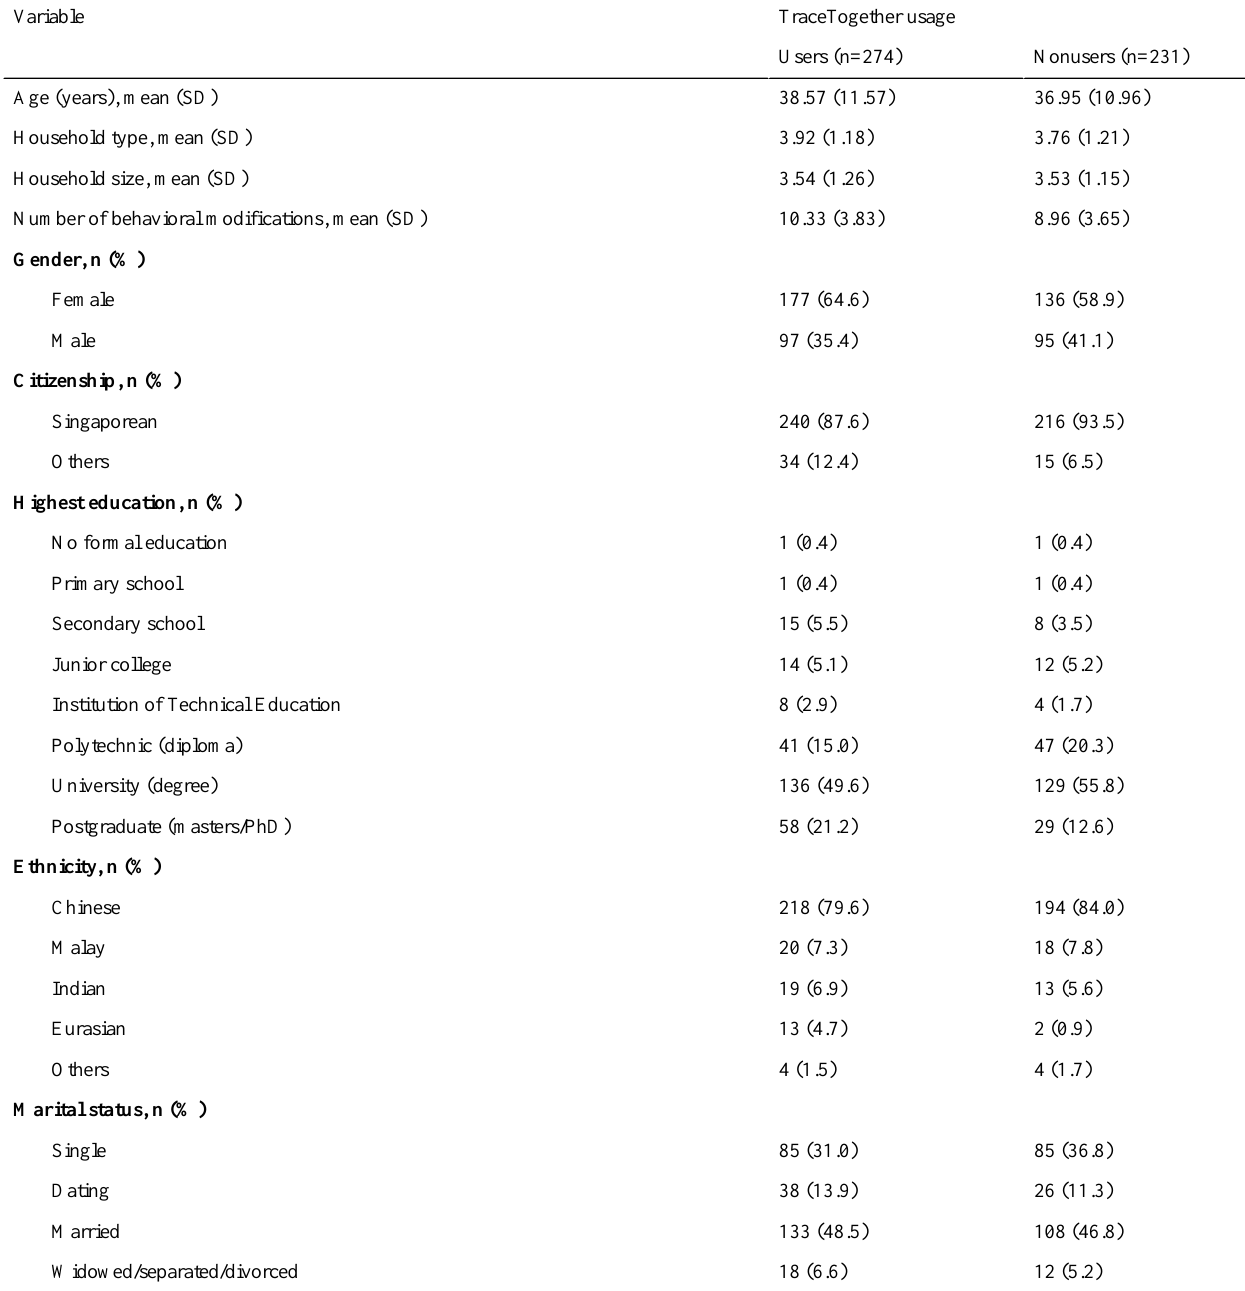
Table 2. Characteristics of the users of TraceTogether